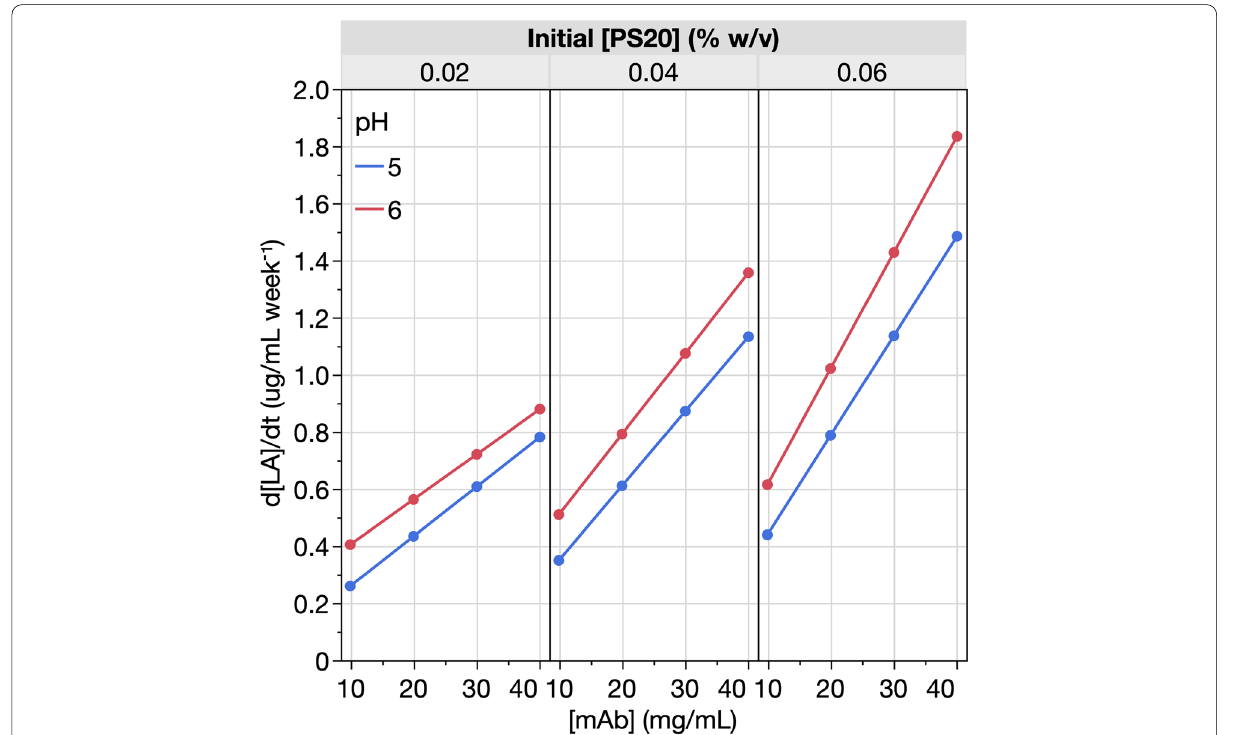
Fig. 9 Rate of change in [LA] as a function of [mAb] in mAb X DP stored at 5 °C. The 24 formulations (listed in Table 1) represent unique combinations of [mAb], initial [PS20], and pH. LA represents the most abundant degradant from PS20 hydrolysis. [LA] in each formulation was quantified by LC–MS. The rate of change in LA concentration (d[LA]/dt) was calculated as the derivative from fitting the longitudinal